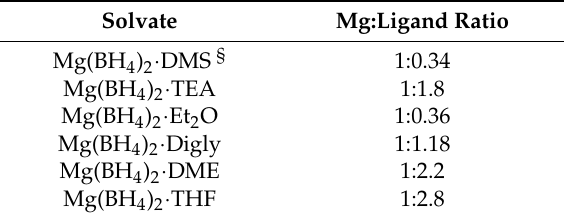
Table 1. Ligand ratios in synthesized solvates, determined by 1 H